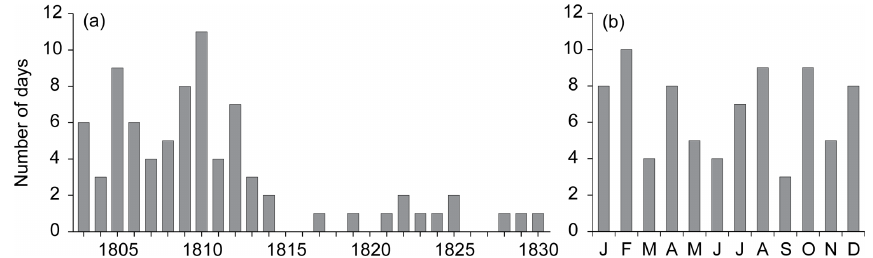
Figure 4. Days missing from daily weather records kept by Šimon Hausner at Buchlovice during 1803–1830 (a) and their annual varia- tion (b)